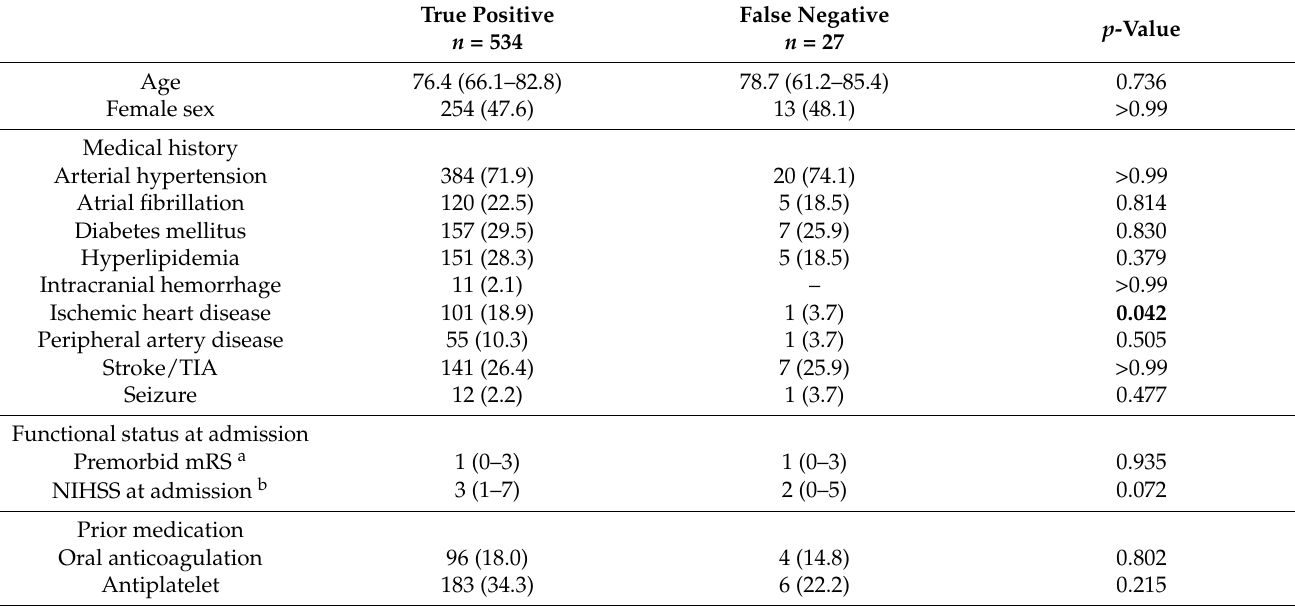
Table A2. Comparison of patient characteristics of true-positive vs. false-negative initial cerebrovascular diagnoses ( n =